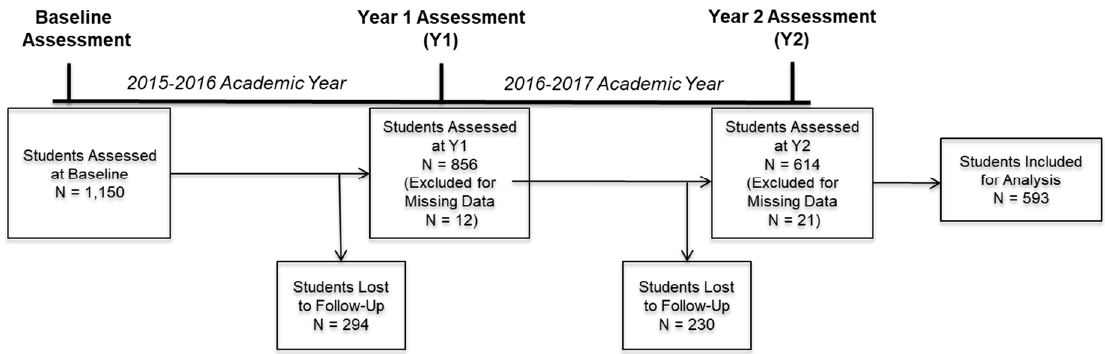
Figure 1. Participant enrollment and participation at baseline (Fall 2015) and each subsequent data collection timepoint, spring 2016 and spring